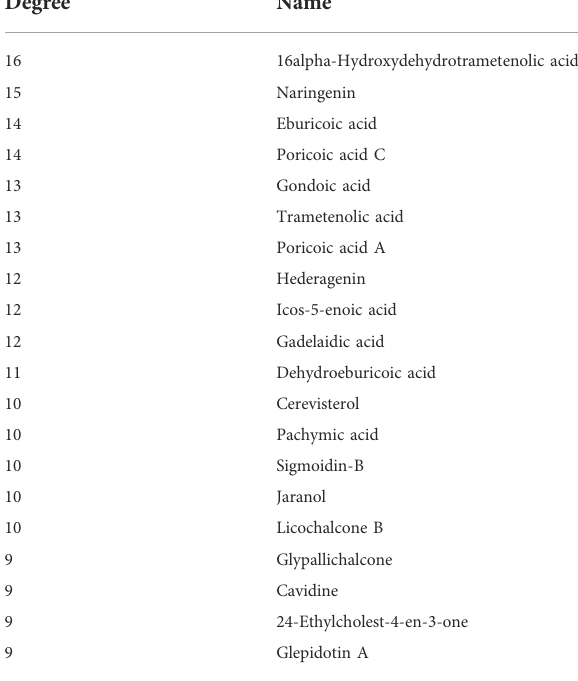
TABLE 3 Top 20 active